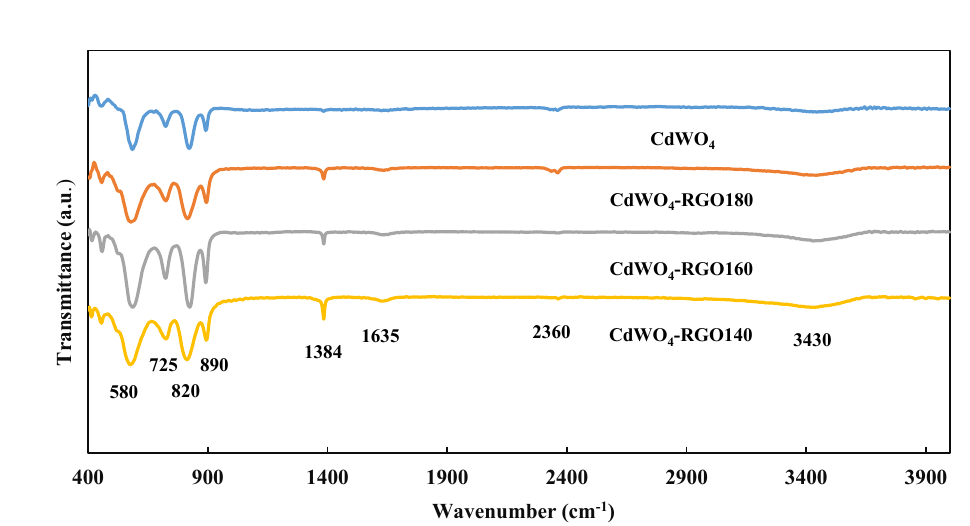
Fig. 3. FT-IR spectra of the pure CdWO